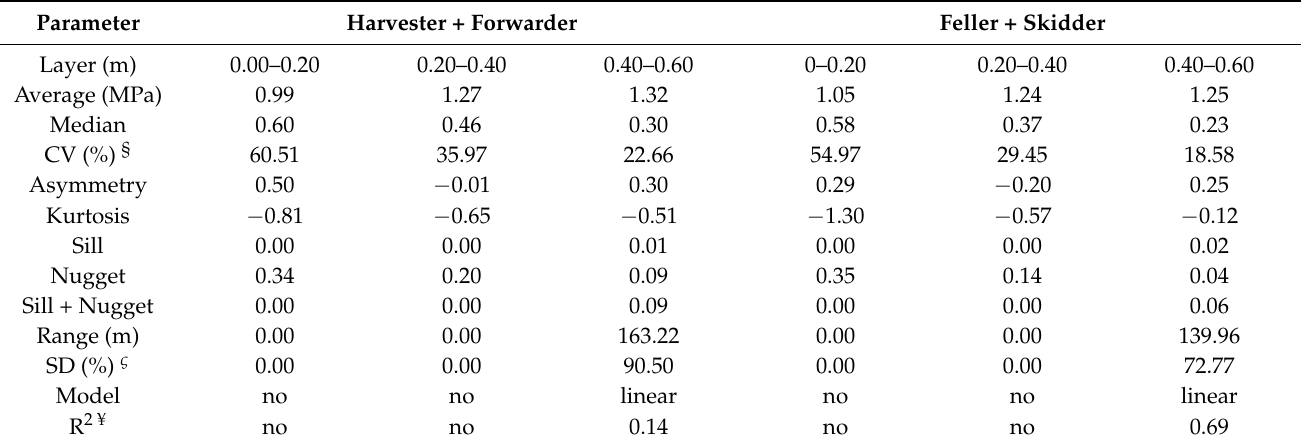
Table 3. Geostatistical parameters for soil penetration resistance (PR) at the 0–0.20, 0.20–0.40